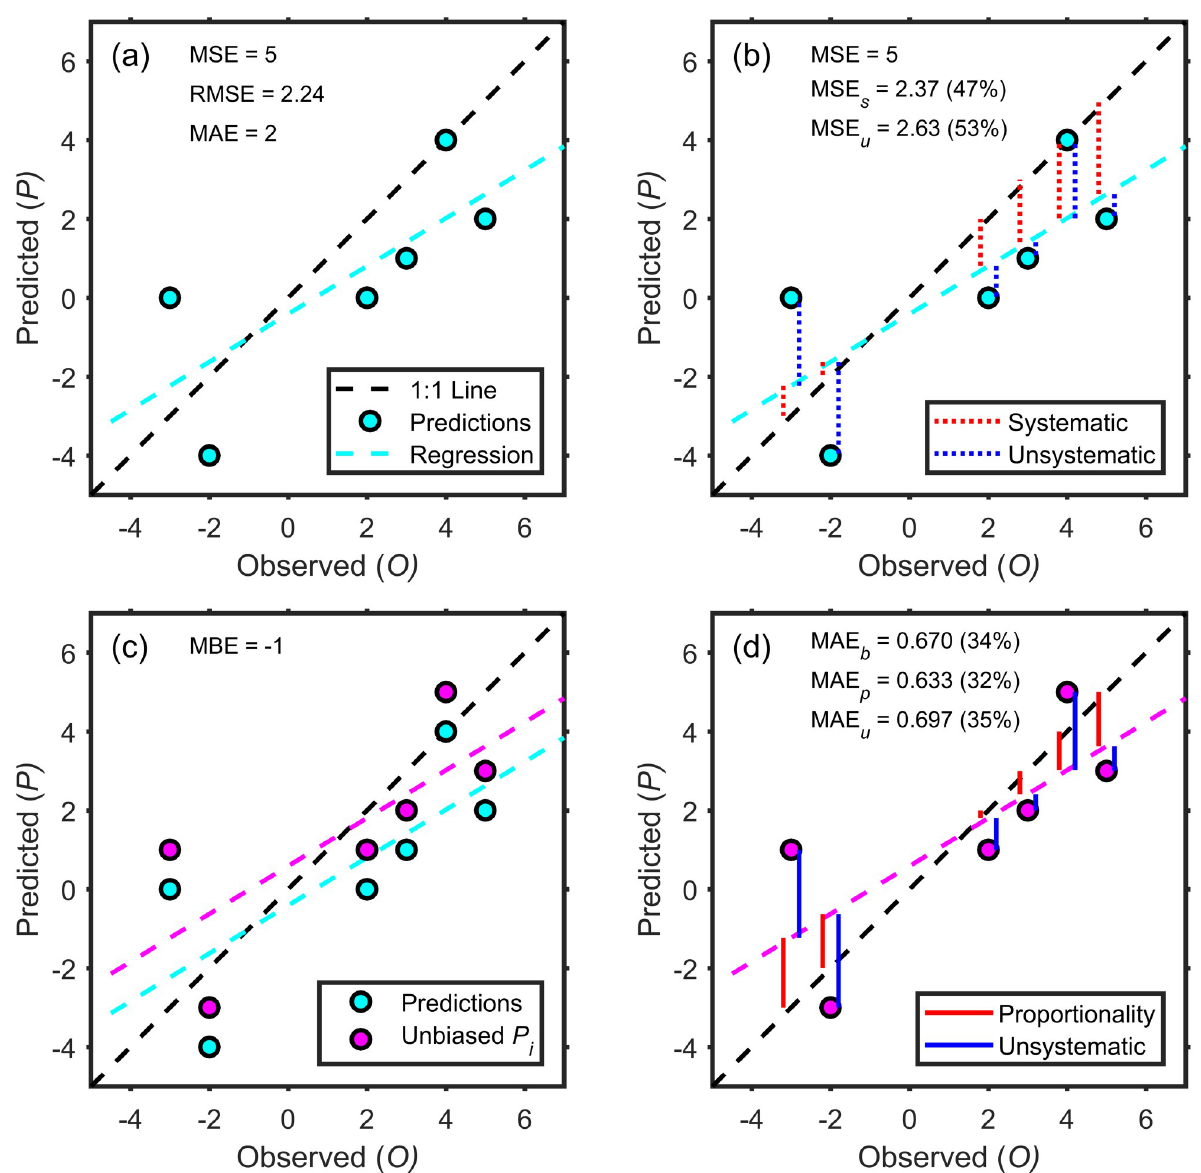
Fig 1. Representations of model-prediction errors showing aspects of the decomposition into systematic and unsystematic components (using data from Table 1). Predictions (in the upper left panel) can be decomposed in the traditional way using MSE, as shown in the upper-right panel where the lengths of the red and blue dotted vertical lines determine the partitioning of the errors. The bottom-left panel shows the predictions after bias is removed (i.e., P 0 ), while the bottom-right panel shows the magnitudes of the bias, proportionality, and unsystematic components of our three- i part, weight-based decomposition of MAE.